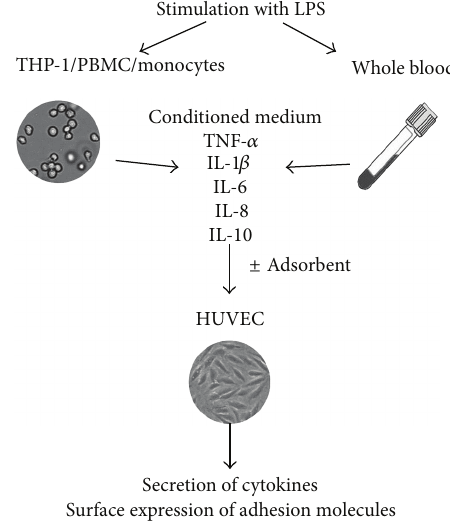
Figure 1: Scheme of the cell culture model. THP-1 cells, peripheral blood mononuclear cells (PBMC), monocytes, or whole blood are stimulated with lipopolysaccharide (LPS). The harvested condi- tioned medium containing LPS and cytokines is treated with adsor- bents to modulate mediators of inflammation and is subsequently used to stimulate human umbilical vein endothelial cells